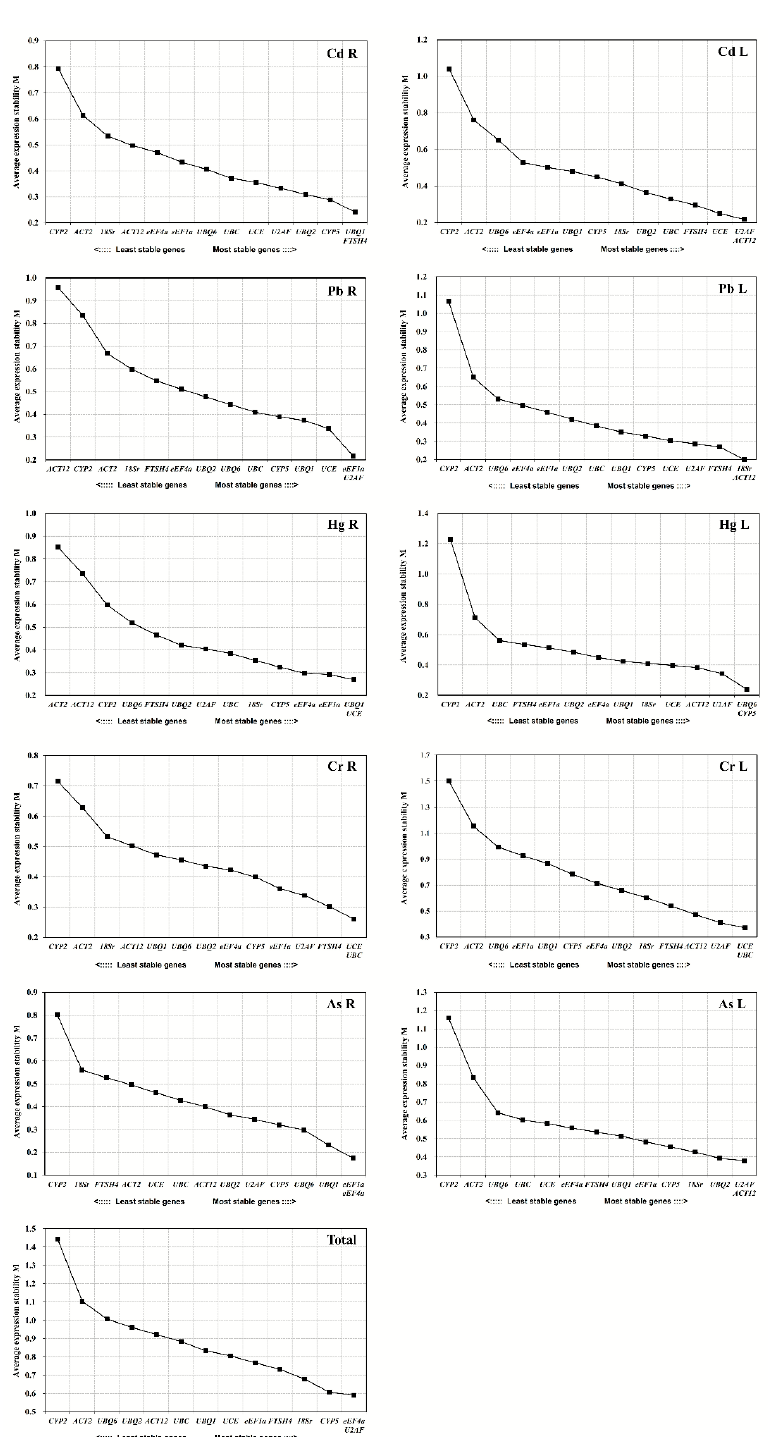
Figure 2. Expression stability measurement (M) for fourteen candidate reference genes in switchgrass root and leaf samples under heavy metals stress conditions.